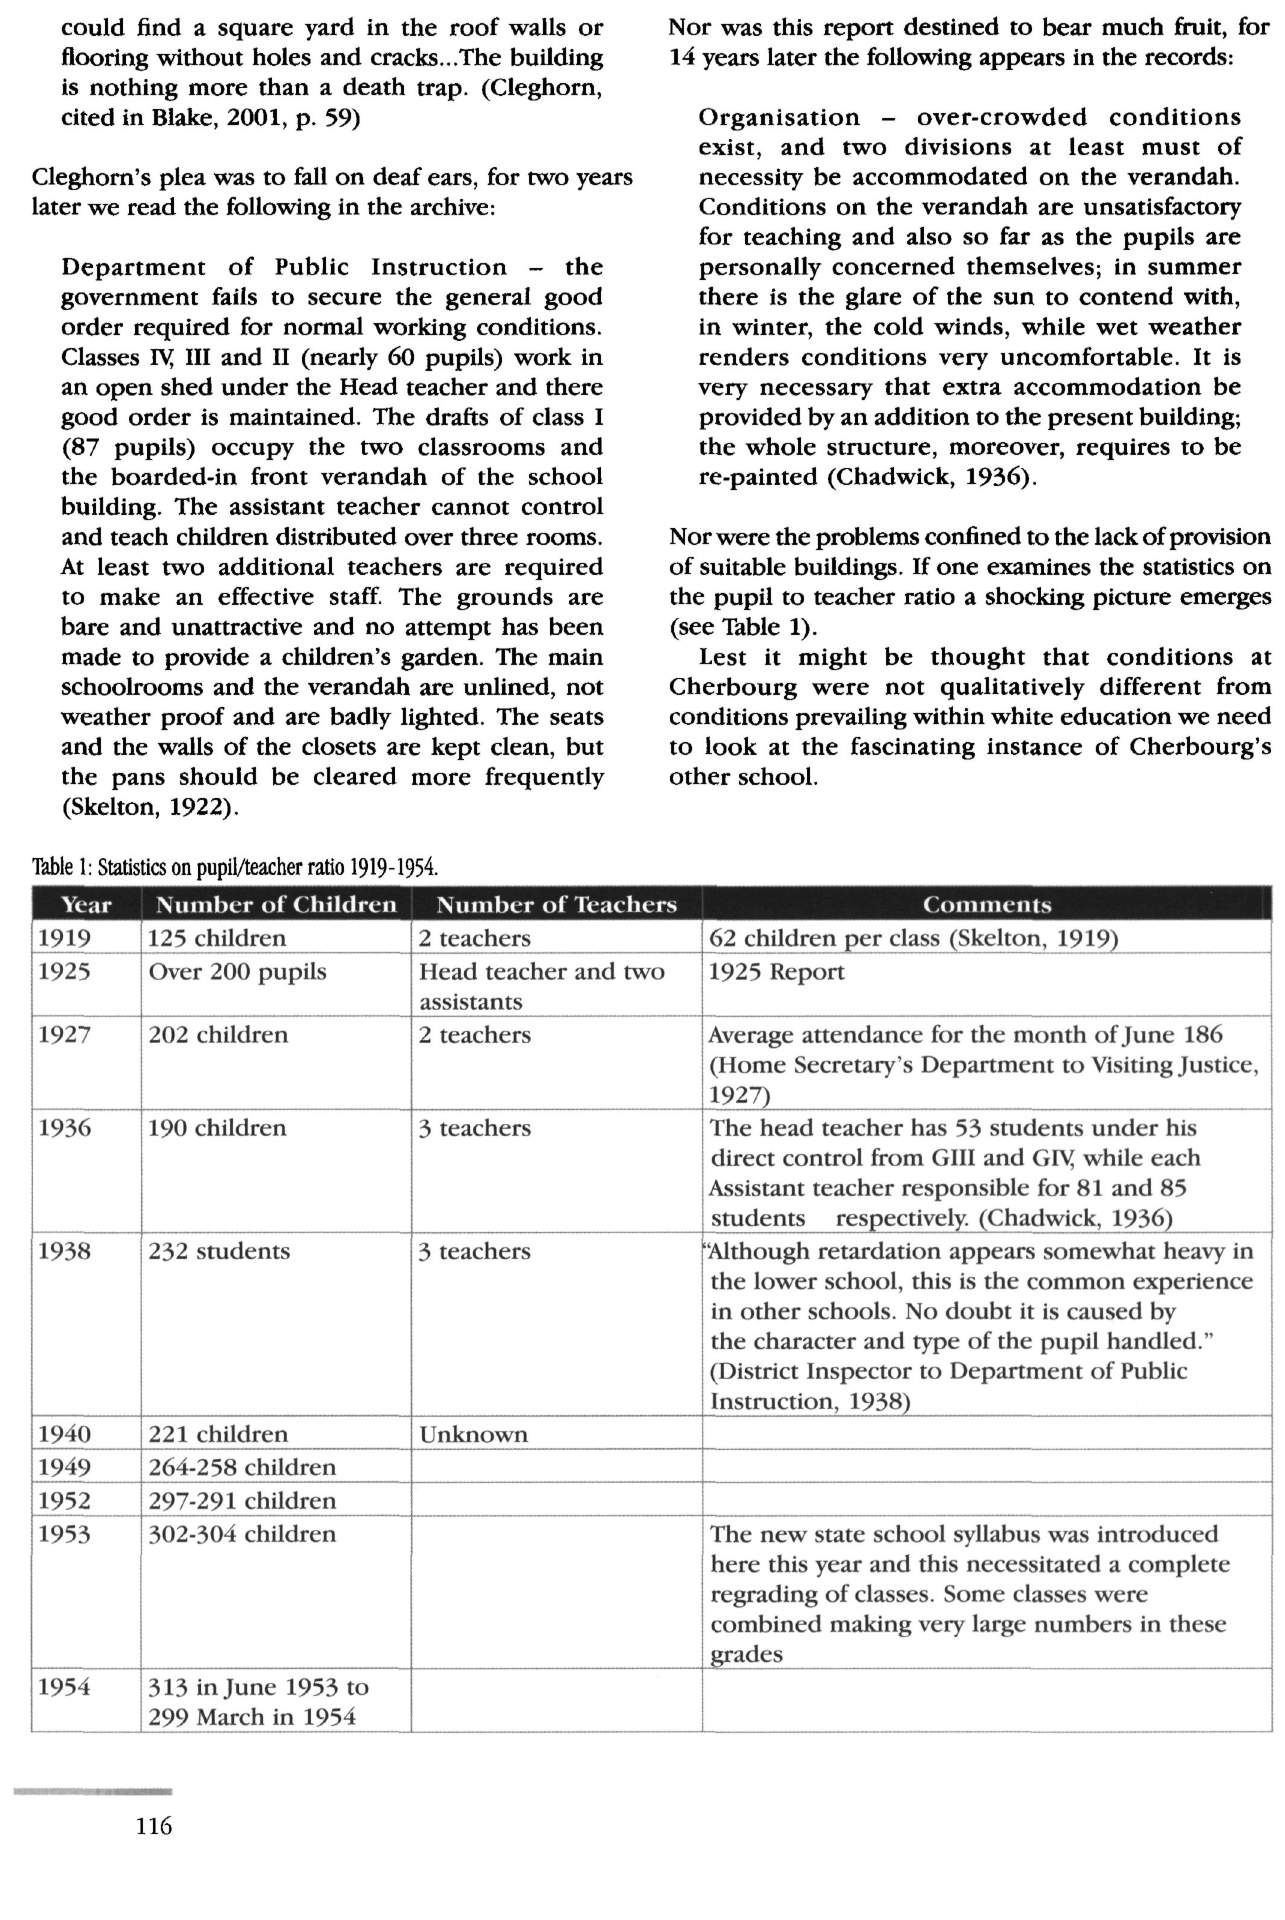
Table 1: Statistics on pupil/teacher ratio